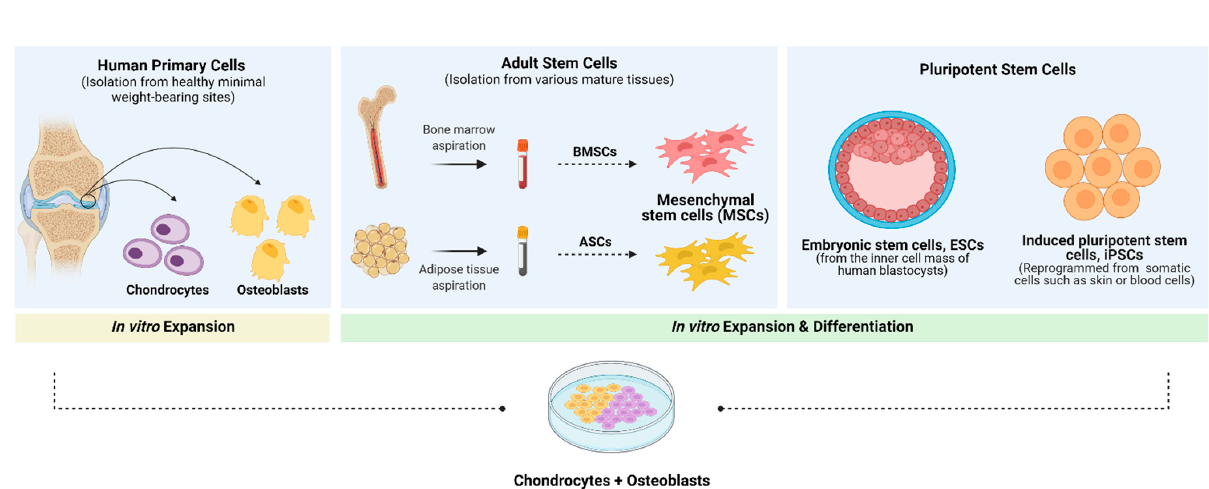
Figure 4. Cell sources explored in the context of cartilage and bone tissue engineering. In contrast to primary cells, which can be derived from healthy load-bearing joints and exhibit the desired osteogenic and chondrogenic phenotypes, adult and pluripotent stem cells need to be expanded, differentiated and/or genetically manipulated to obtain the appropriate cell type. Adult stem/progenitor cells can be isolated from mature tissues such as the bone marrow (via percutaneous bone marrow aspiration) or adipose tissue (via liposuction) and will give rise to bone marrow-derived mesenchymal stem cells (BMSCs) and adipose-derived stem cells (ASCs), respectively. Embryonic stem cells (ESCs) are isolated from the inner cell mass of human blastocysts and induced pluripotent stem cells (iPSCs) can be reprogrammed from human somatic cells such as skin or blood cells, giving rise to chondrogenic and osteogenic cell populations. Created with BioRender.com (accessed on 2 June